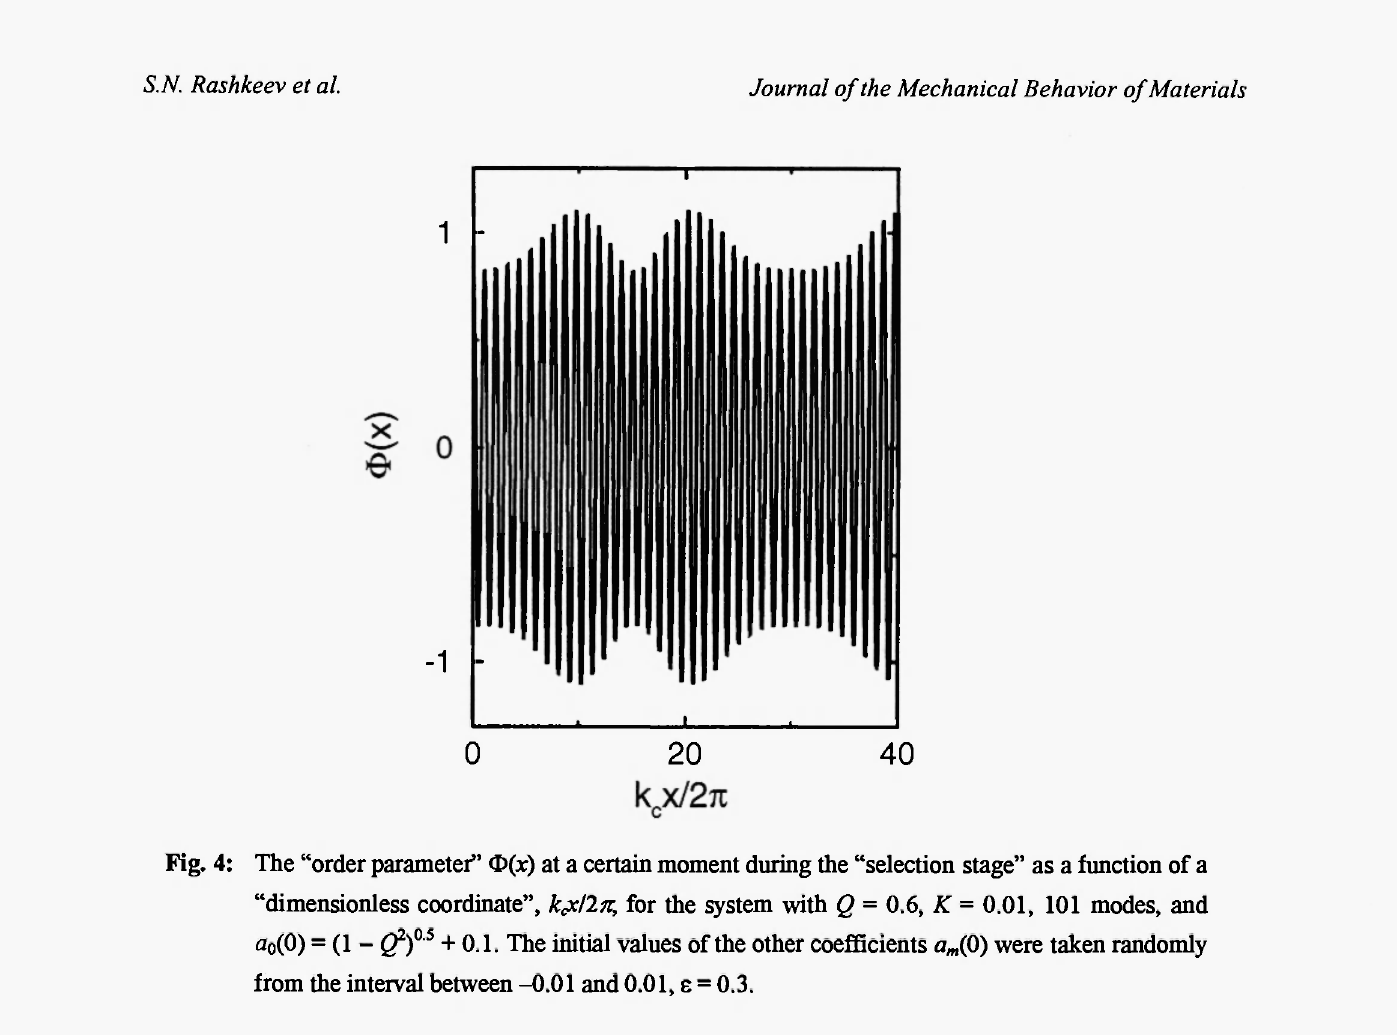
(0) were taken randomly m